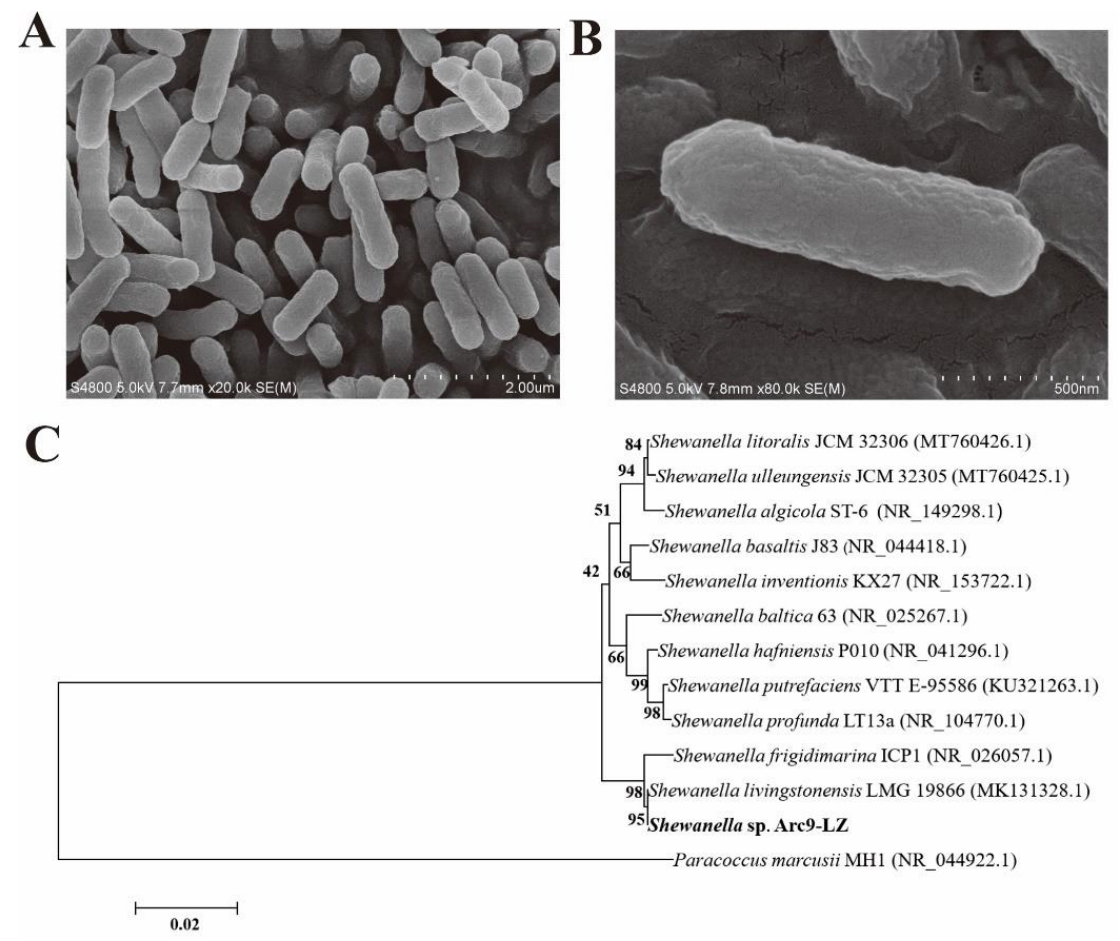
Figure 1. SEM results of the stain Shewanella sp. Arc9-LZ ( A , B ). Phylogenetic tree based on 16S rRNA gene sequences, Bootstrap ≥ 1000. GenBank accession numbers are indicated in parentheses ( C ).